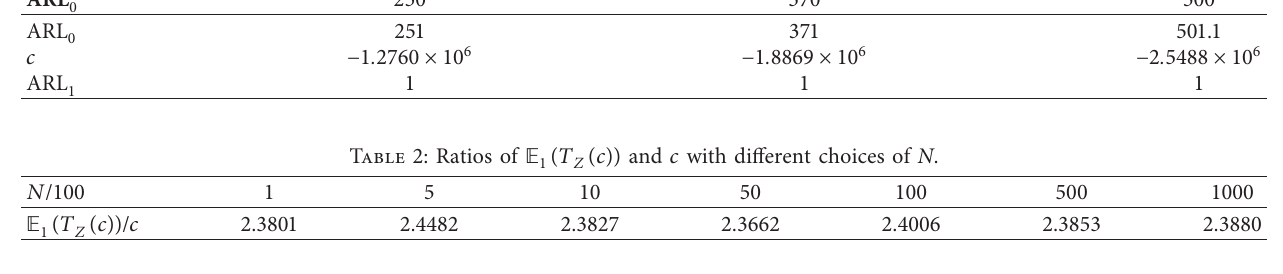
Table 1: Simulation values of ARL